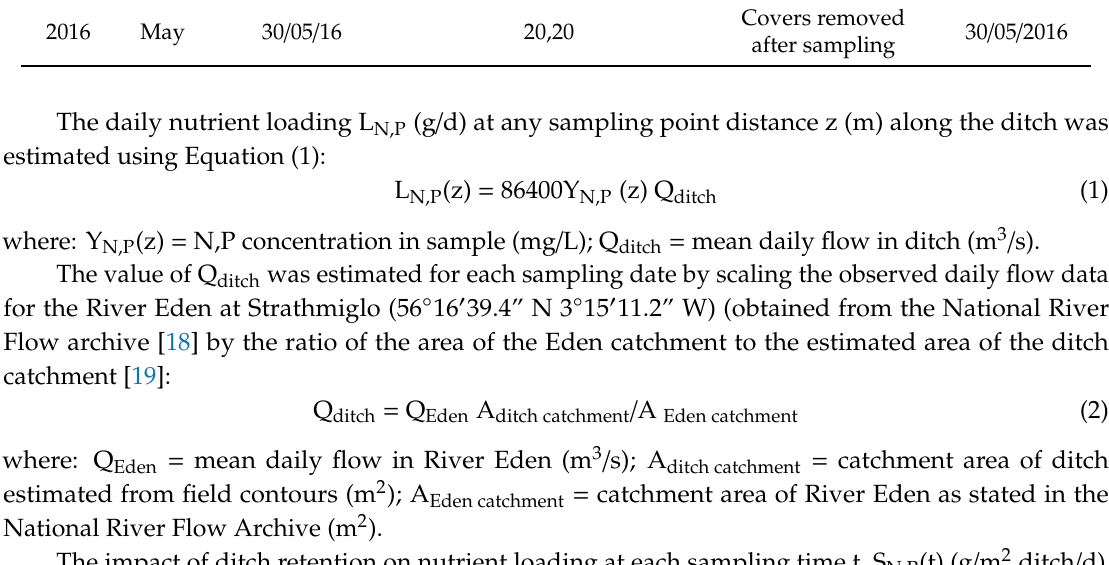
10 / 06 / 2015 30 / 05 /